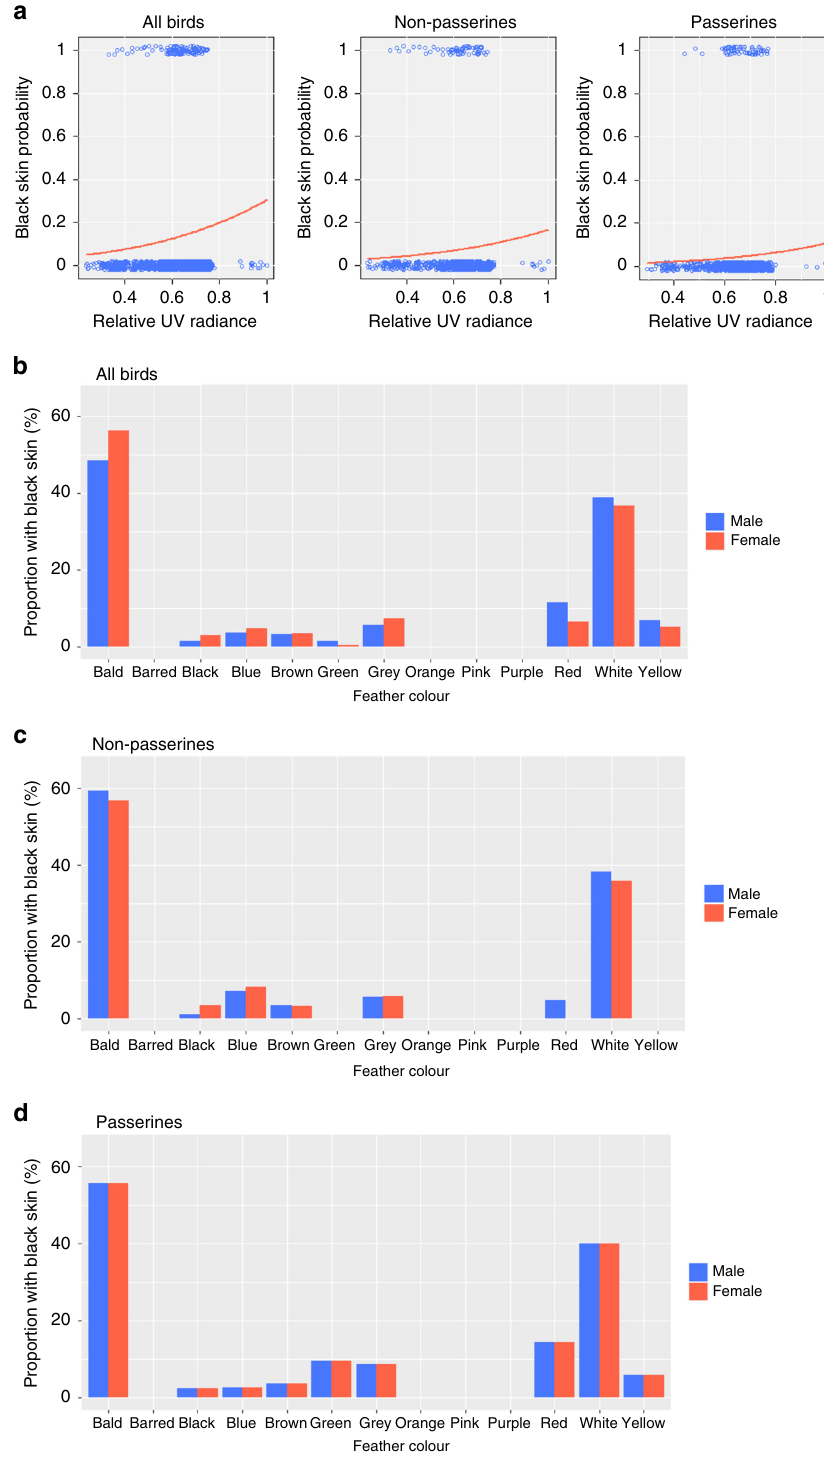
Fig. 3 Black skin in function of UV radiance and feather colour. a Black skin probability in function of relative UV radiance (UV radiance/max UV radiance) for all birds, non-passerines and passerines (data shown for female dataset only). Observed proportion of black skin relative to non-black skin in function of feather colour for all birds ( b ), non-passerines ( c ) and passerines ( d ) (Supplementary Table